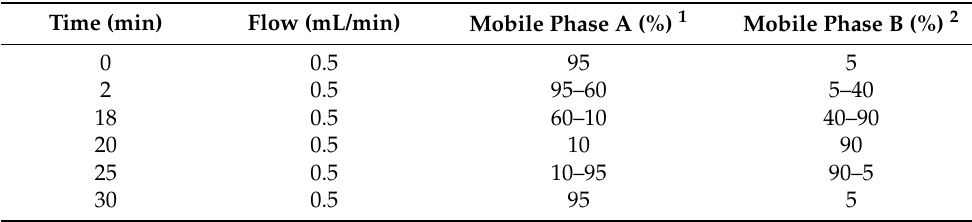
Table 1. Parameters of HPLC mobile phases elution